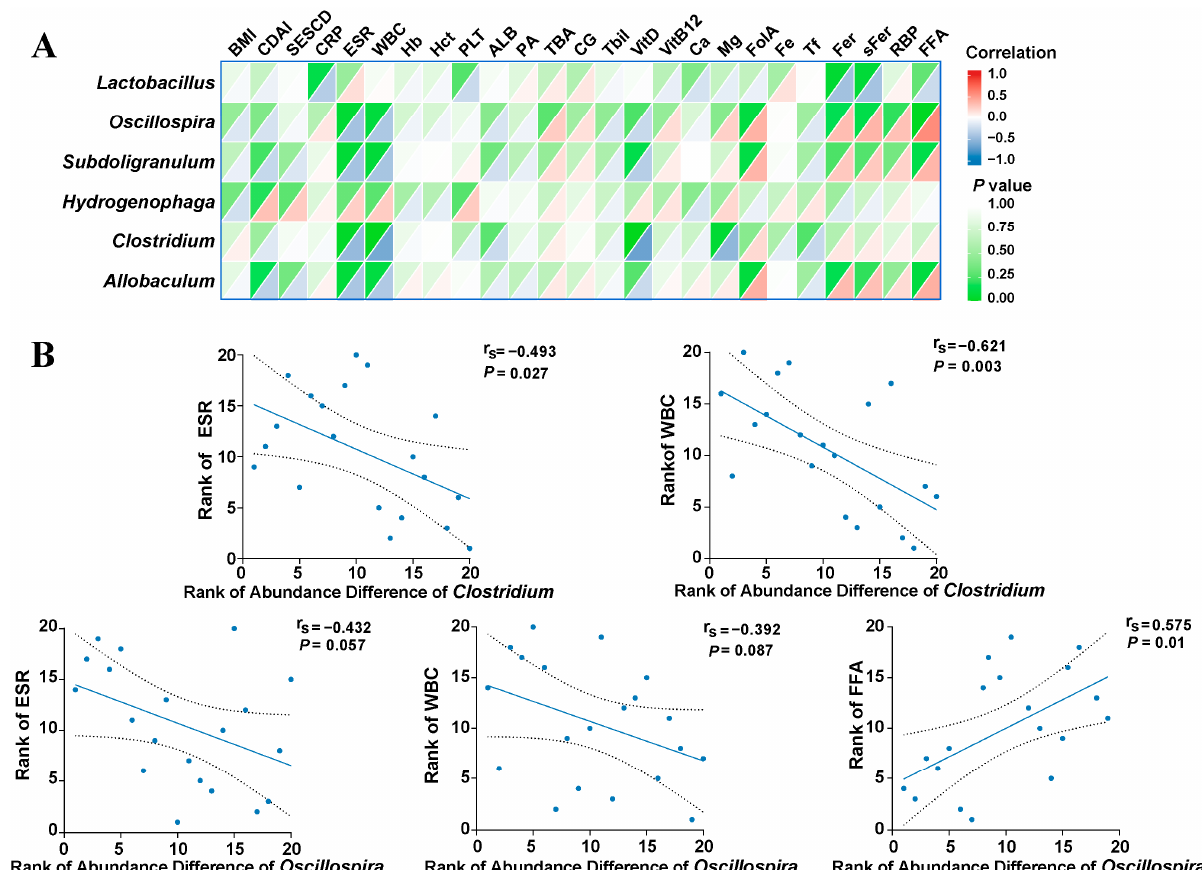
Figure 3. Correlations between bacterial abundance difference (stenotic site vs. non-stenotic site) and clinical indexes. ( A ): Heatmap showed the correlations between different genera and inflammatory indicators; ( B ): Spearman’s rank correlation analysis between Genus Oscillospira or Clostridium and clinical indexes. Every blue dot represents an enrolled patient and its location in the coordinate axis represents the rank of bacterial difference between two sites of this patients as well as the rank of his corresponding clinical index. BMI: body mass index; CDAI: Crohn’s disease activity index; SES-CD: simple endoscopic score for Crohn’s disease; CRP: C-reactive protein; ESR: erythrocyte sedimentation rate; WBC: white blood cell; Hb: hemoglobin; Hct: hematocrit; PLT: blood platelet; ALB: albumin; PA: prealbumin; TBA: total bile acid; CG: cholyglycine; Tbil: total bilirubin; VitD: vitamin D; VitB12: vitamin B12; FolA: folic acid; Tf: transferrin; Fer: ferritin; sFer: serum ferritin; RBP: retinol-binding protein; FFA: free fatty acids.